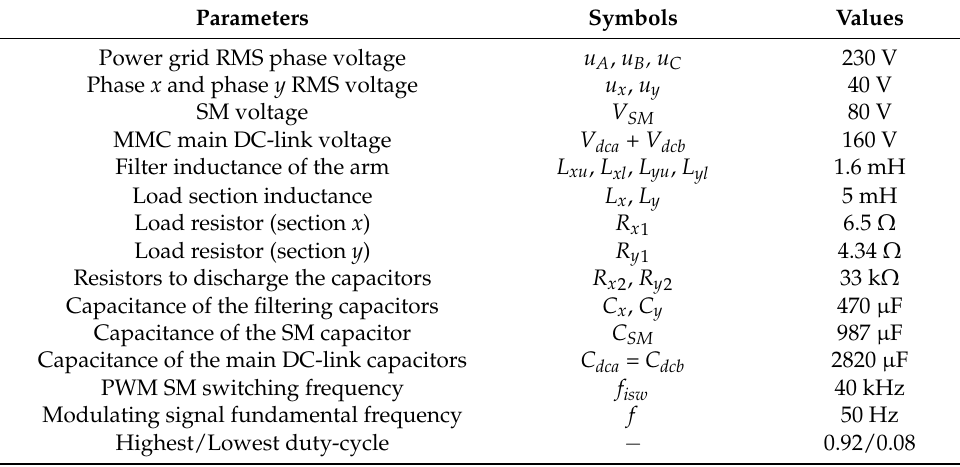
Figure 17. Schematic of the RPC based on half-bridge MMC experimental setup. Table 2. Experimental parameters of the RPC based on half-bridge